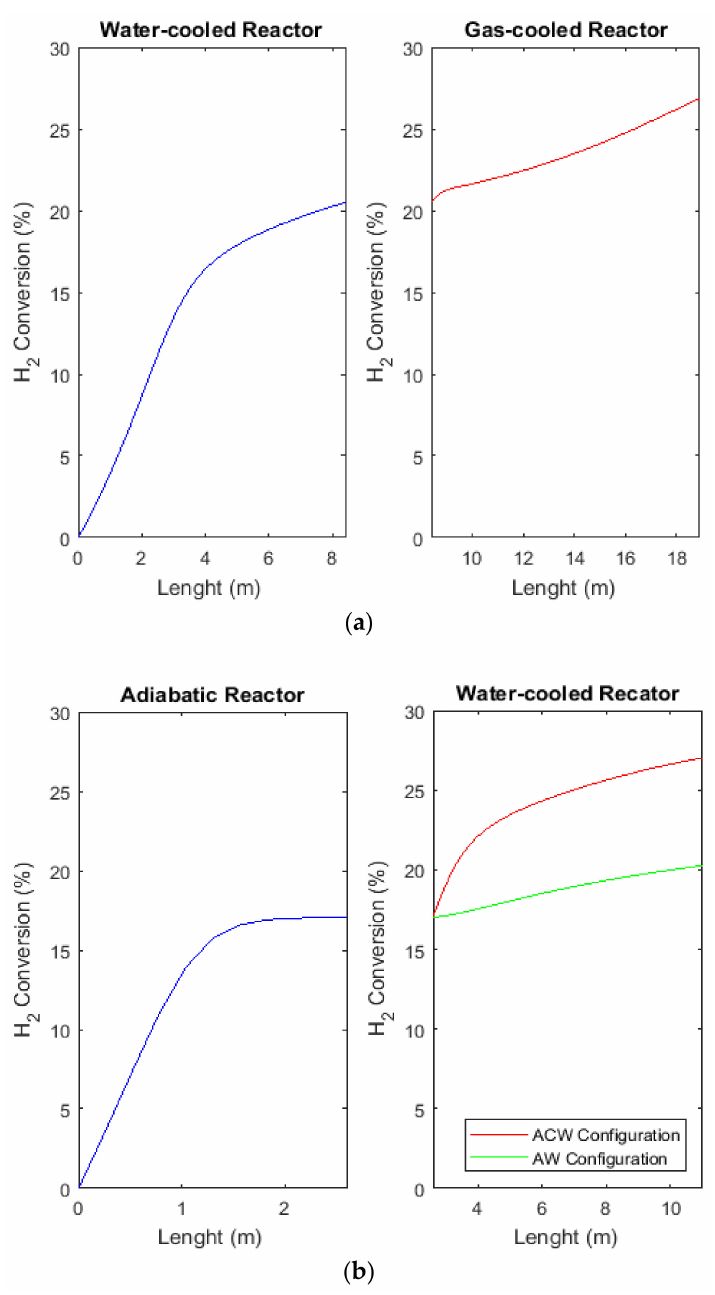
Figure 6. H 2 conversion along reactors in ( a ) CR configuration; and ( b ) AW and ACW